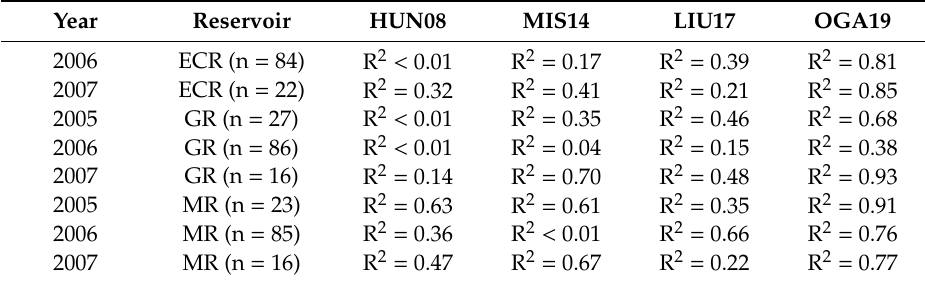
Figure 3. Average R rs (sr − 1 ) spectra for each dataset. Table 3. Coefficients of Determination for semi-empirical PC estimation algorithms calibrated on the 2005–2007 datasets. Best performances are highlighted in bold. Year